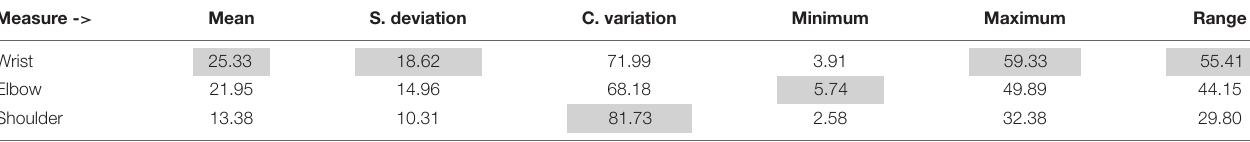
TABLE 2 | Mean descriptive statistics of the dissimilarity measure between successive movement trajectories in real scenarios over the trials. Measure - >